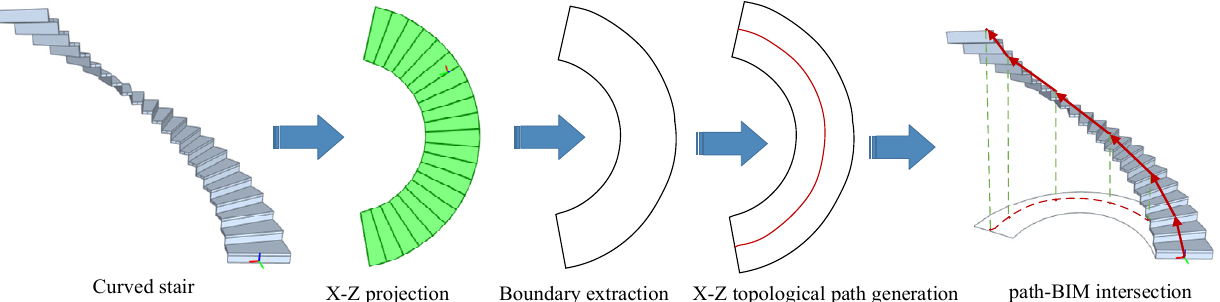
Figure 3. A four-step process for the generation of a 3D topological path from a cross-floor element.